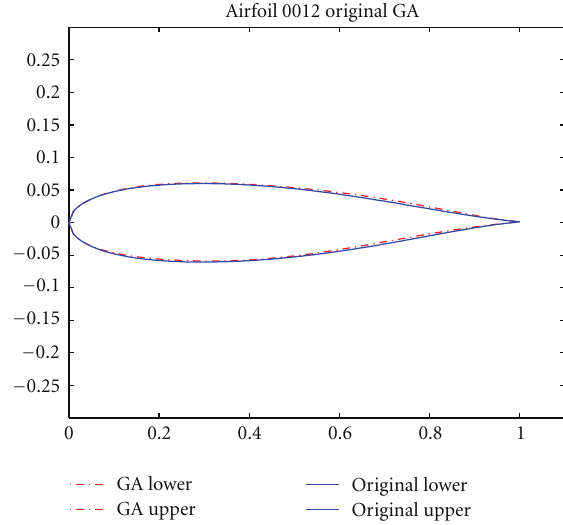
Figure 3: Original NACA 0012 airfoil versus optimized airfoil using